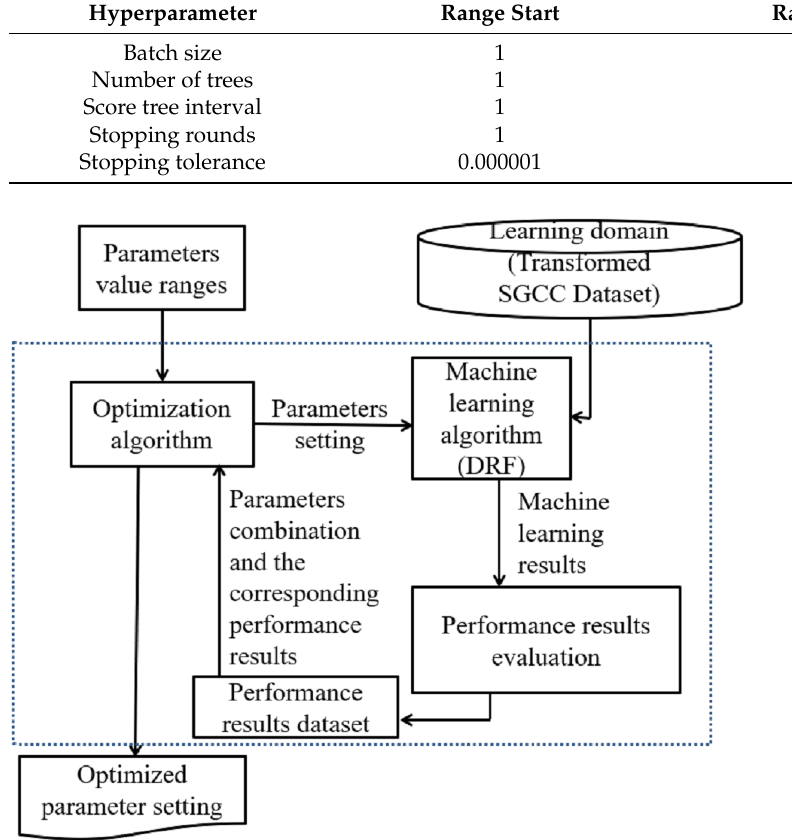
Figure 4. Hyperparameter tuning and